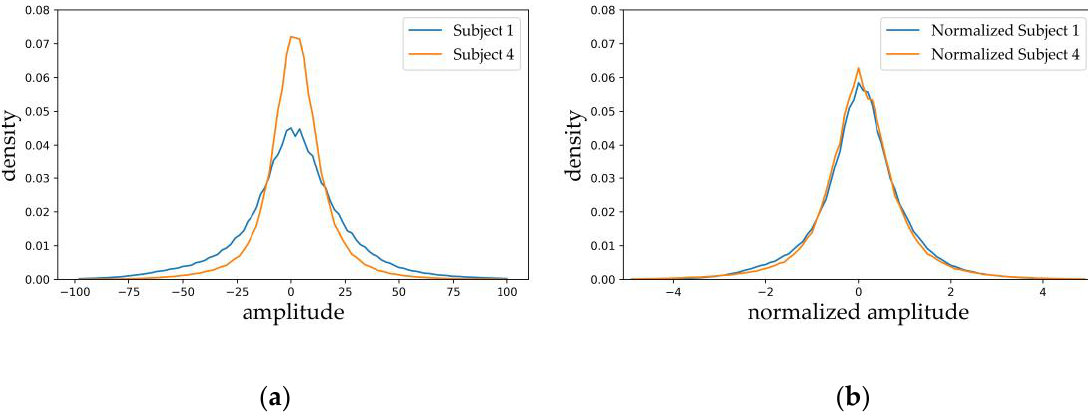
Figure 2. EEG signal amplitude distribution: ( a ) raw data; ( b ) normalized data.